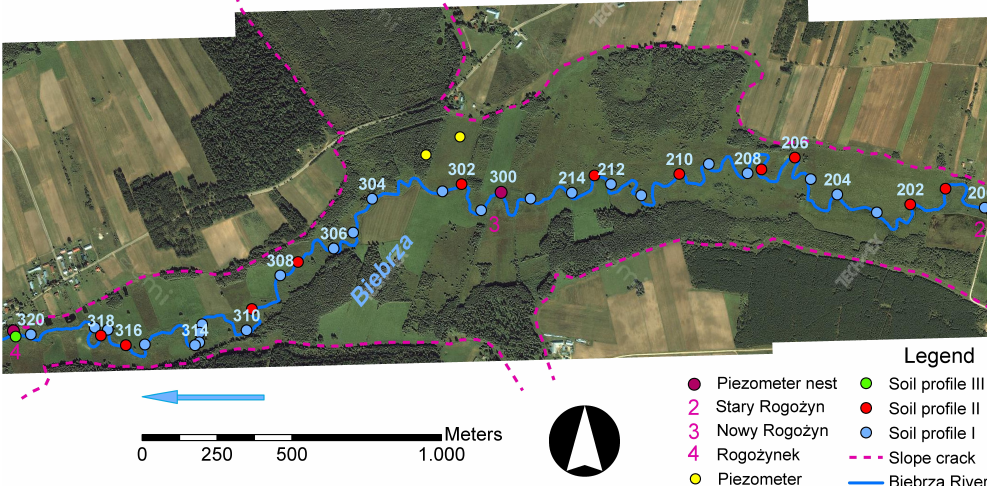
Fig. 3. Location of the 38 points (blue, red and green points) of the T-Stick measurements along the Biebrza River. The purple dots indicate the location of piezometer nests. The dashed line indicates the maximum extent of the alluvium or floodplain (i.e. the slope crack between valley wall and valley floor); a tributary is entering the alluvium from the south, in the north the alluvium extents into a paleochannel of the Biebrza River. On the right side of the alluvial plain, two piezometer nests are indicated. Orthophotomap source: www.zumi.pl.